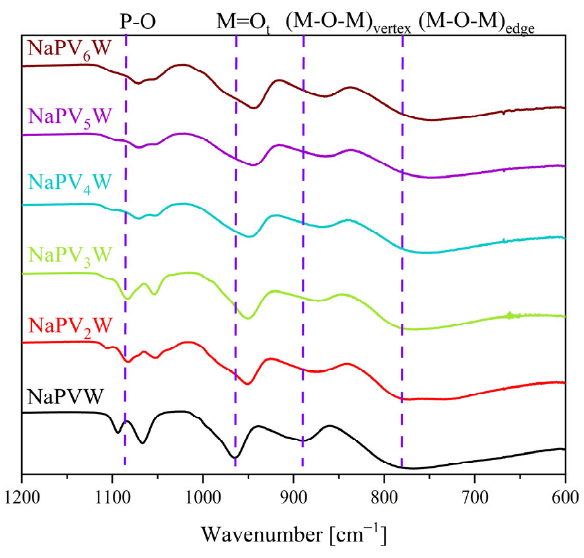
Figure 1. ATR ‐ FT ‐ IR spectra of the POMs NaPV x W, with x = 1 to 6. Figure 1. ATR-FT-IR spectra of the POMs NaPV x W, with x = 1 to 6.